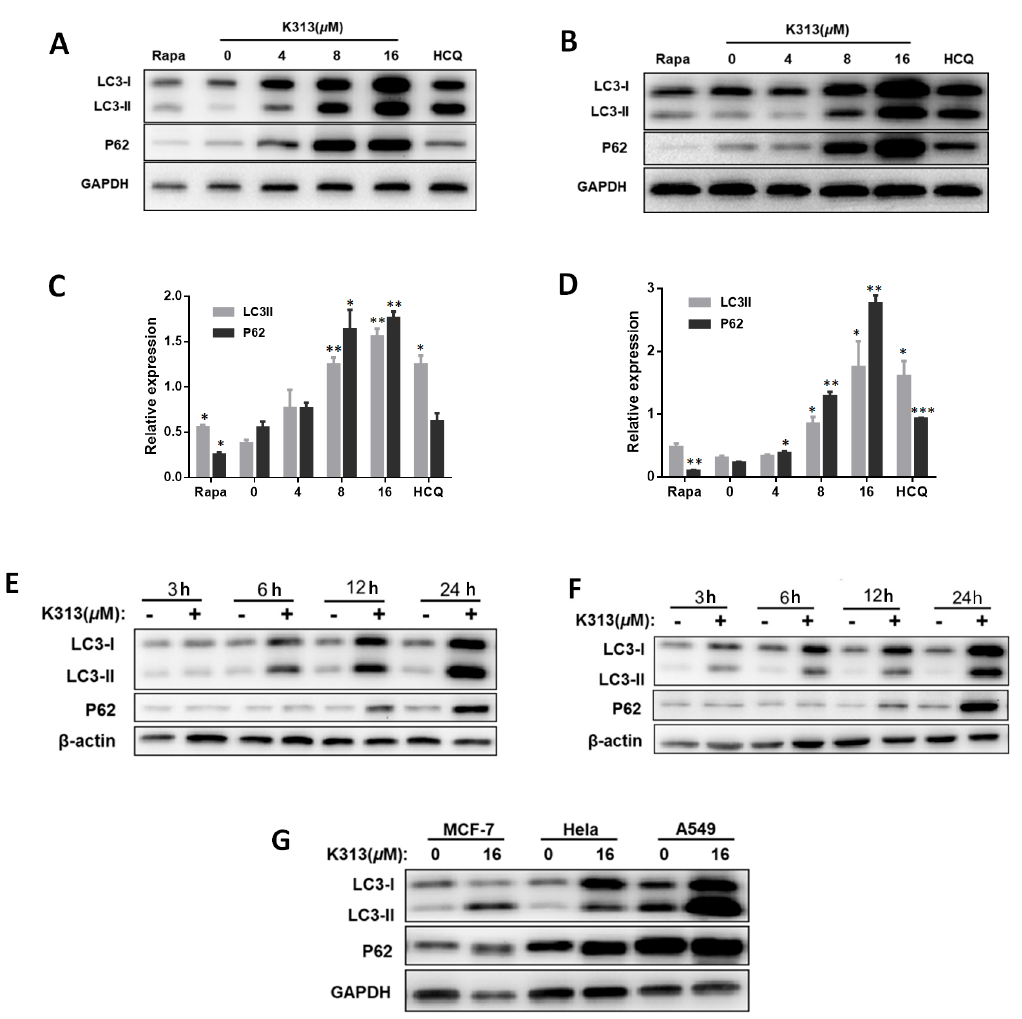
Figure 6. K313 induces autophagy blockage in Nalm-6 and Daudi cells in a dose- and time-dependent manner. Different concentrations of K313, 5 µM rapamycin, and 20 µM hydroxychloroquine (HCQ) were used to treat ( A ) Nalm-6 and ( B ) Daudi cells for 24 h. Then, the whole cell lysates were analyzed by Western blotting using LC3 and P62 antibodies. Quantitative analyses of protein levels were conducted in ( C ) Nalm-6 and ( D ) Daudi cells. Further, 8 µM K313 was used to treat ( E ) Nalm-6 and ( F ) Daudi cells at different time-points, and the total cell lysates were analyzed by Western blot. ( G ) After incubation with or without 16 µM K313 for 24 h in MCF-7, Hela, and A549 cells, the whole protein lysates were tested by Western blot using LC3 and P62 protein antibodies. * p < 0.05, ** p < 0.01, and *** p < 0.001 vs. control group.